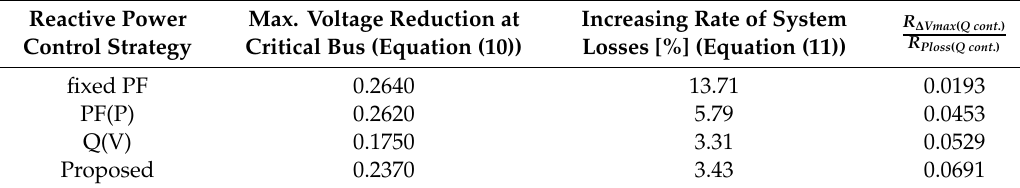
Table 4. Maximum voltage reduction at critical bus and system losses increase rate of reactive power